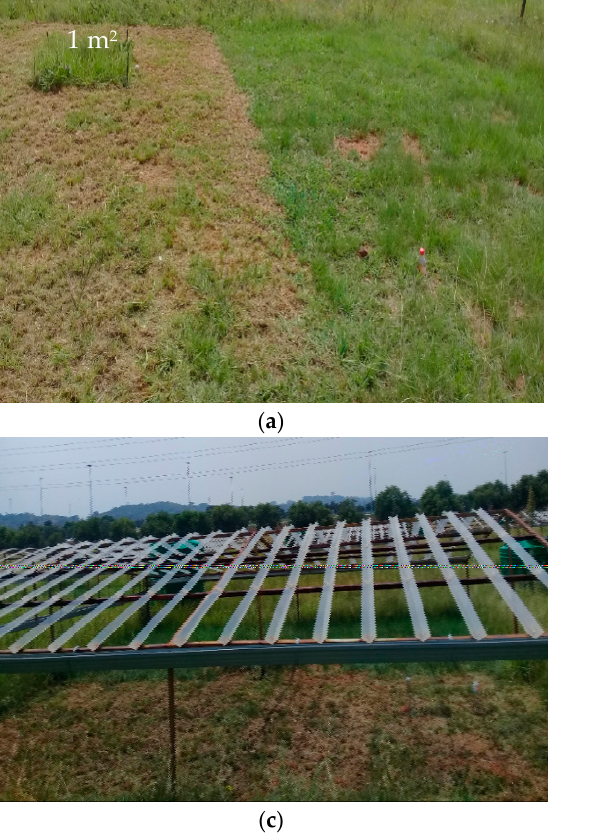
Figure 3. Rainfall distribution across different months and years. 3. Statistical Analysis The data on the ANPP were subjected to the general linear model (PROC GLM) pro- cedure of [27] to determine the main effects of the RR intensities on overall, species func- tional (grasses and forbs) and ecological (decreasers and increasers) groups’ ANPP. The blocks were added as a random factor in the model; however, they are not reported on 050 100